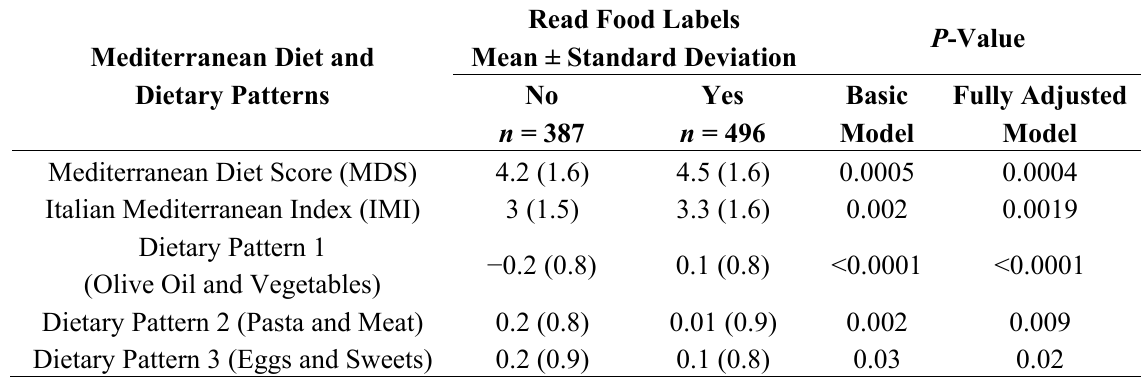
Table 4. Differences in adherence to Mediterranean diet and in dietary patterns between food labels readers and